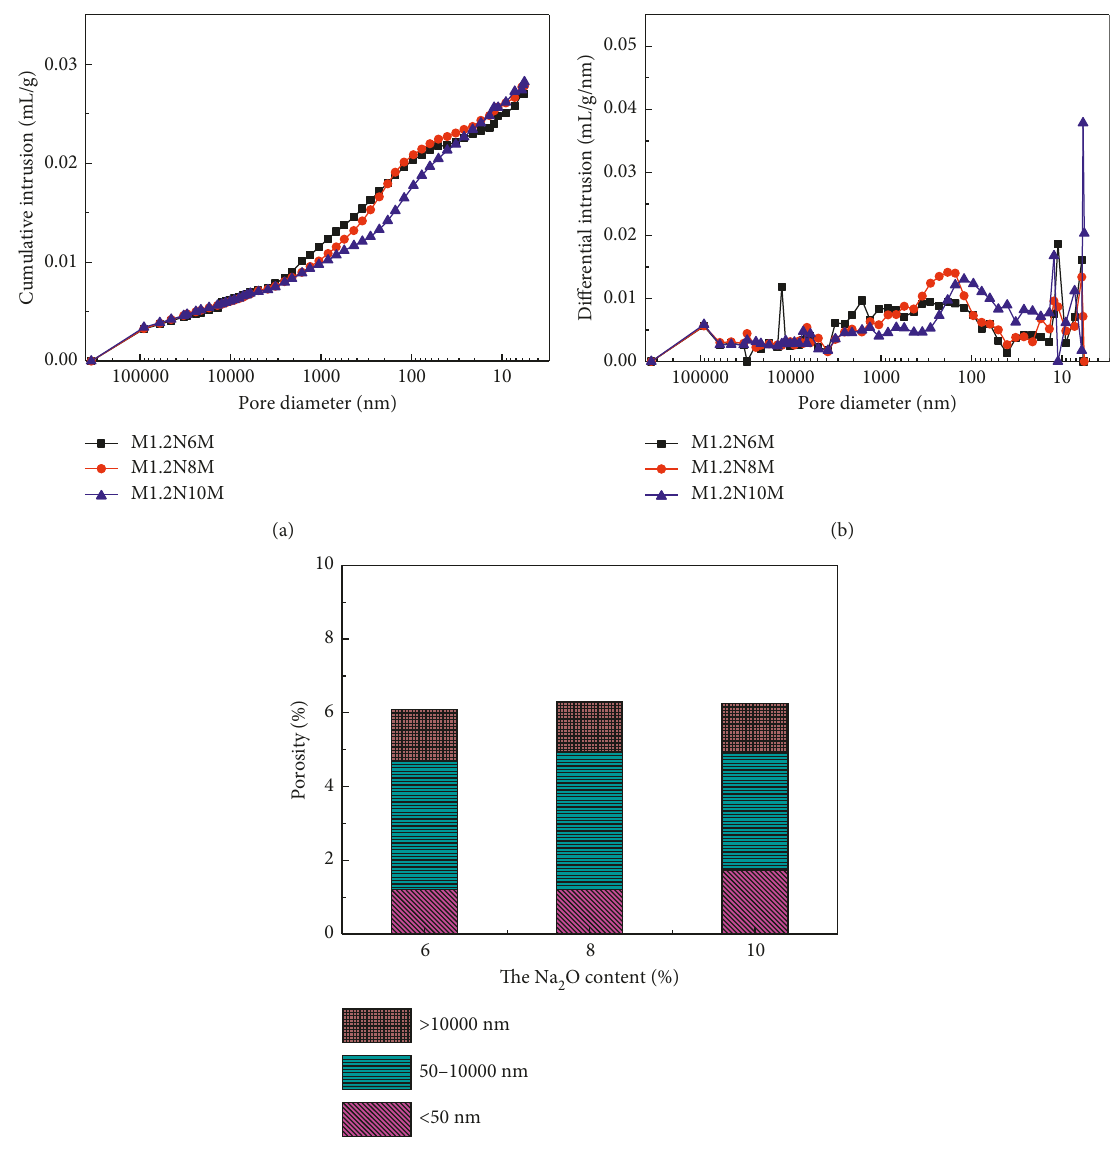
Figure 11: The pore size distribution of AAS mortars with different Na intrusion curves; (c)